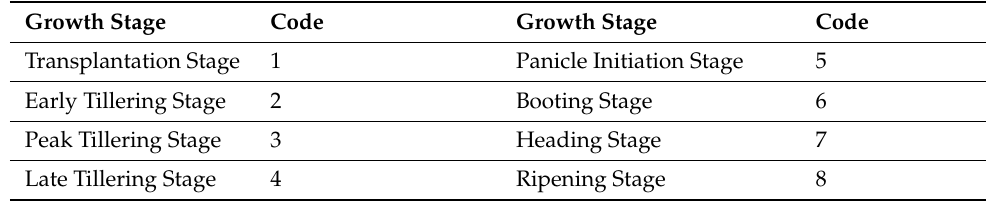
Table 5. Label Code for Each Growth Stage.